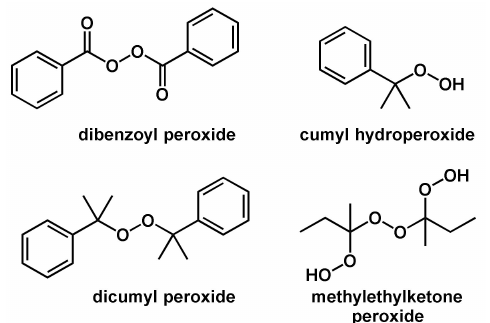
Figure 5. Chemical structures of most commonly used organic peroxide initiators.